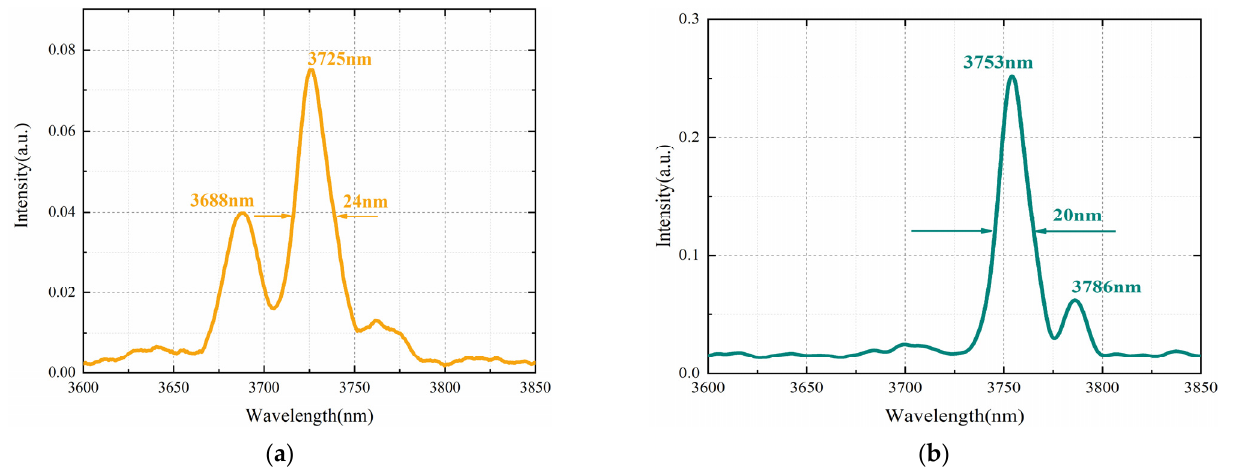
Figure 6. Intracavity DFG generates a double-peaked idler beam with the primary peak at ( a ) 3725 nm and ( b ) 3753 nm. and ( b ) 3753